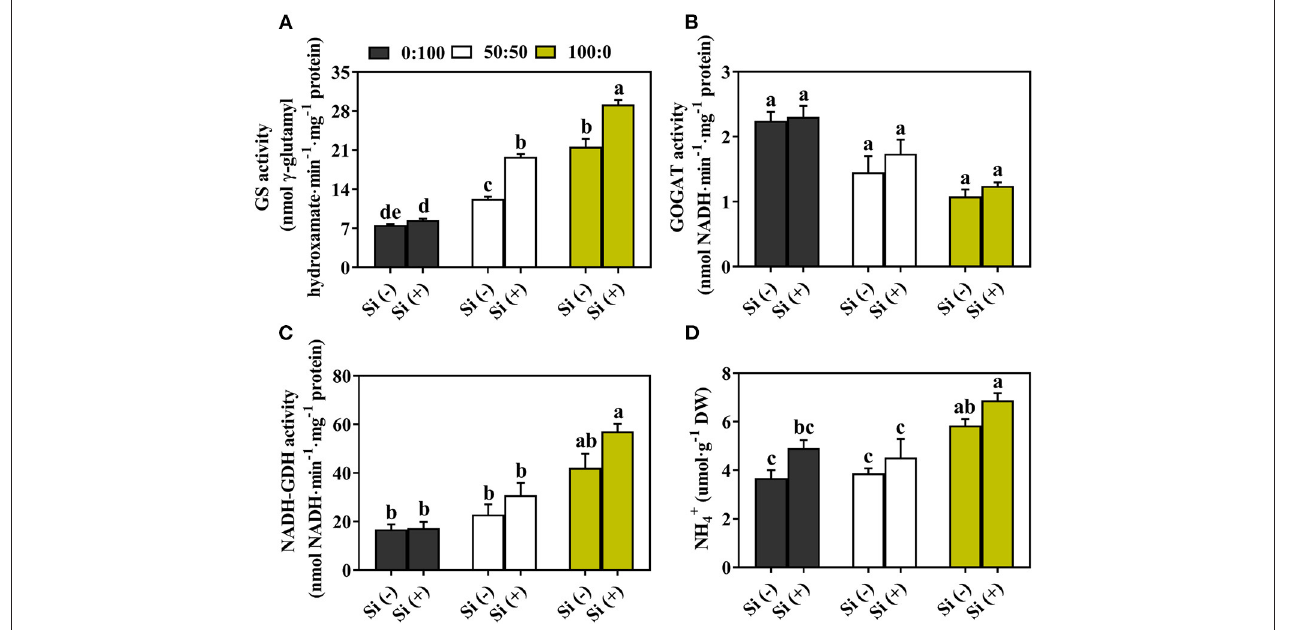
FIGURE 7 | Effects of the NH + 4 :NO − 3 ratio and Si application on the activities of major N assimilation enzymes concerning (A) GS, (B) GOGAT, (C) NADH-dependent GDH and (D) contents of NH + 4 in leaves. Data displayed are means of n = 6 independent replicates ± SD; significant differences were determined by Duncan’s multiple range test at p = 0.05 and shown by different letters over